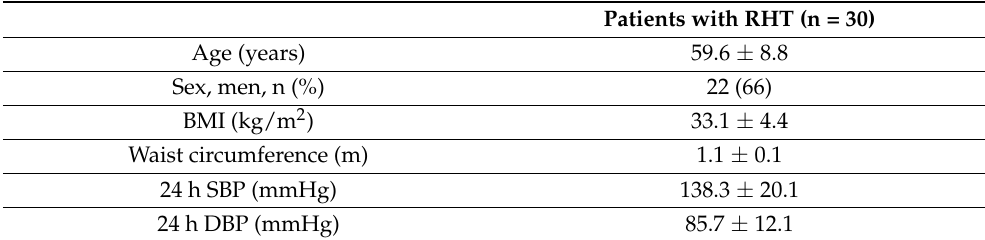
Table 1. Selected characteristics in the study